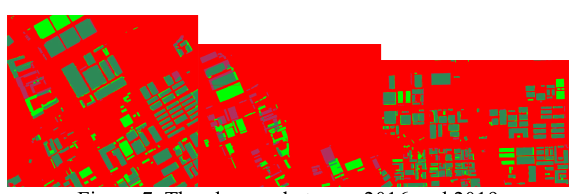
Figure 7. The changes between 2016 and